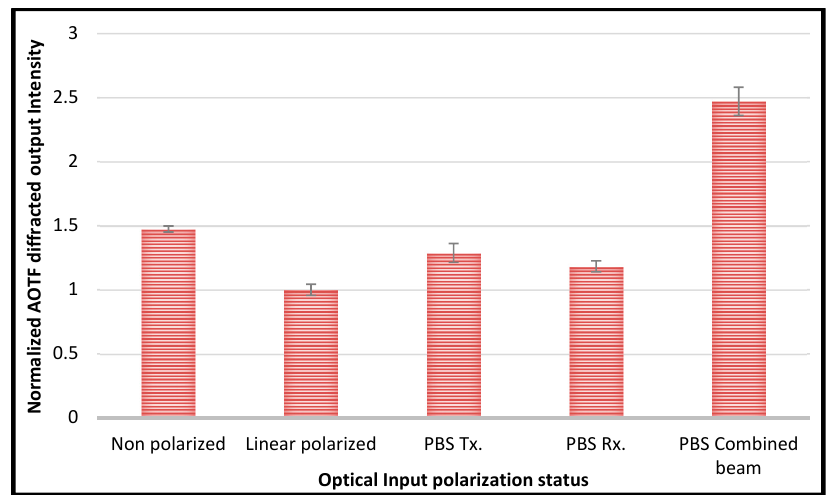
Figure 2. The diffracted light intensity of the AOTF crystal in: (1) randomly polarized input directly passing an AOTF; (2) linearly polarized input (i.e., #1 + linear polarizer) and directly passing an AOTF (polarization aligned with the AOTF optimal direction); and (3) randomly polarized input (i.e., #1) going through the dual polarization setup. The two polarizations paths were measured separately (PBS transmitted, PBS reflected) in addition to the combined beam (PBS dual beams), respectively. All the displayed diffracted intensities are normalized with respect to the linear polarized input.